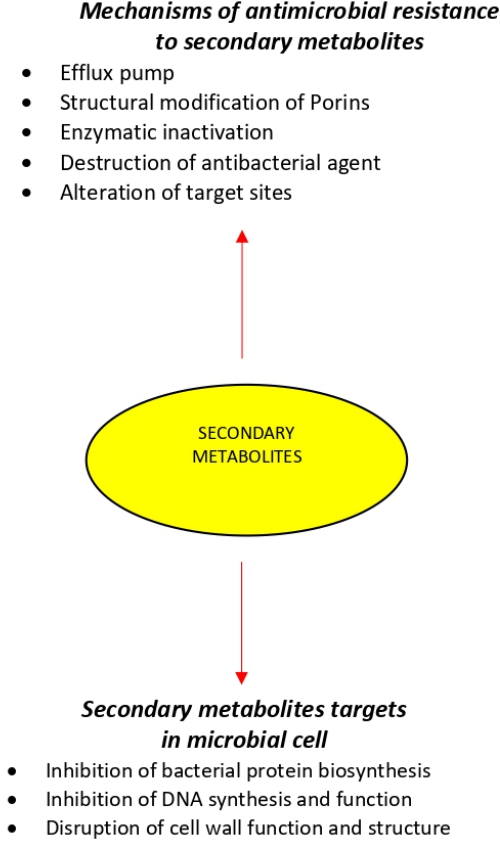
Figure 1. Mechanisms of antimicrobial agents and resistance by pathogens.